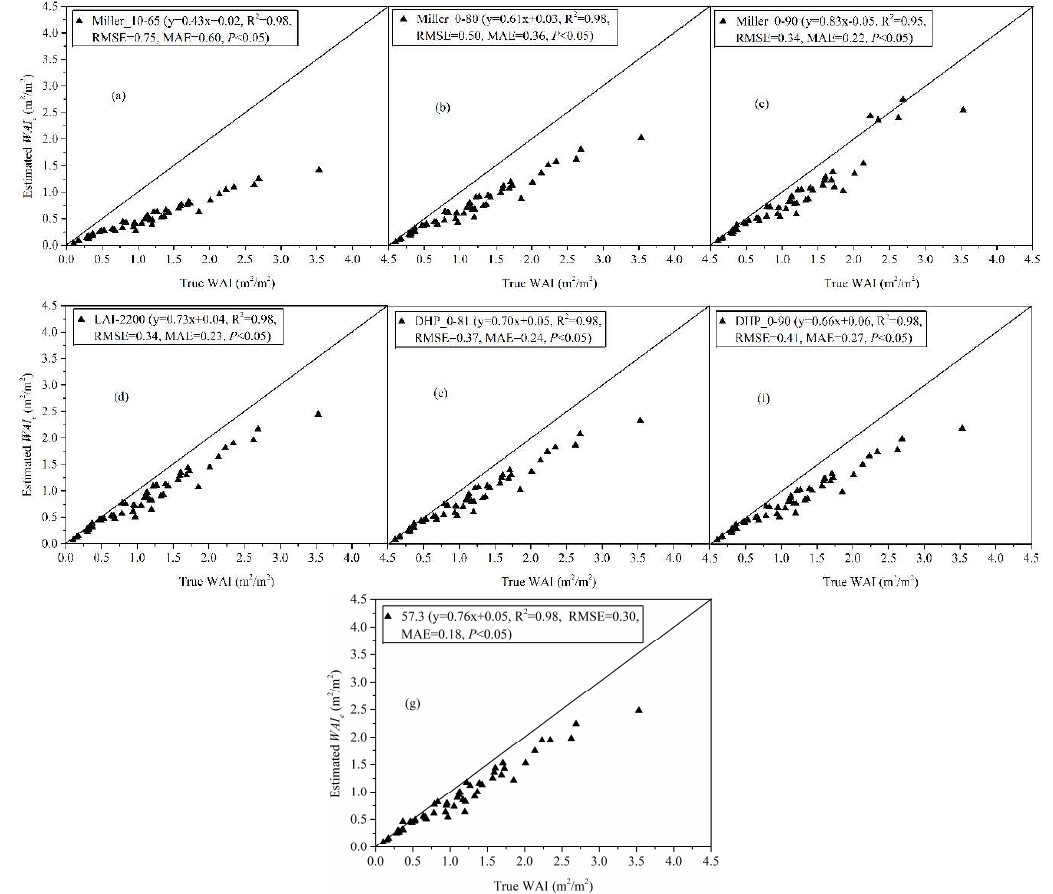
 estimation algorithm and segment size w